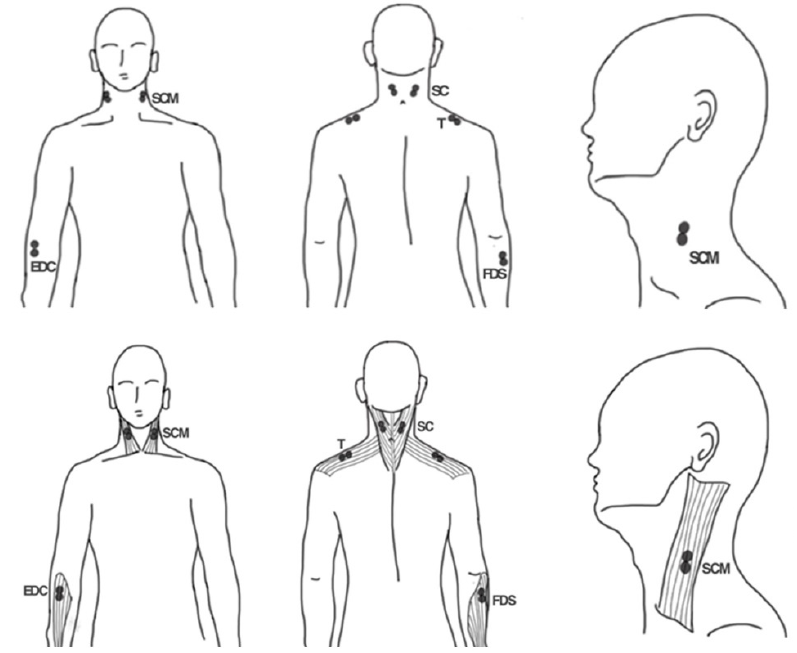
Figure 1. Schematic of the electrode attachment position for electromyography. EDC, extensor dig- itorum communis; FDS, flexor digitorum superficialis; SCM, sternocleidomastoid muscle; SC, sple- nius capitis; T, trapezius